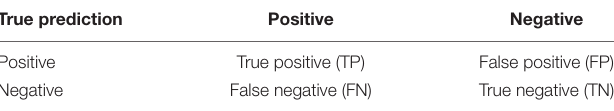
TABLE 1 | Confusion matrix definitions.